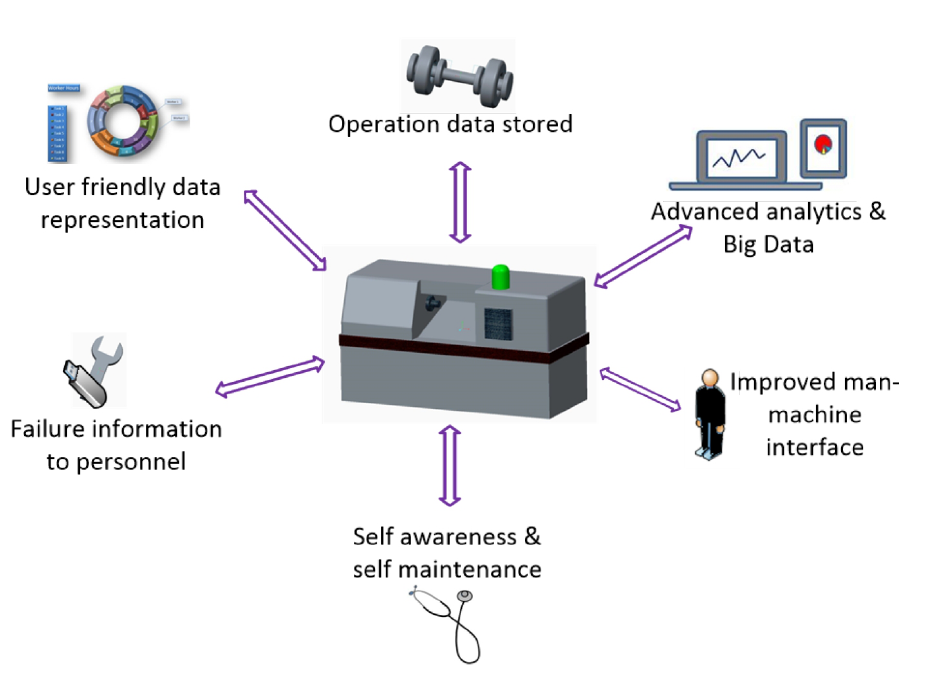
Figure 5. Impact of Industry 4.0 on control and employee